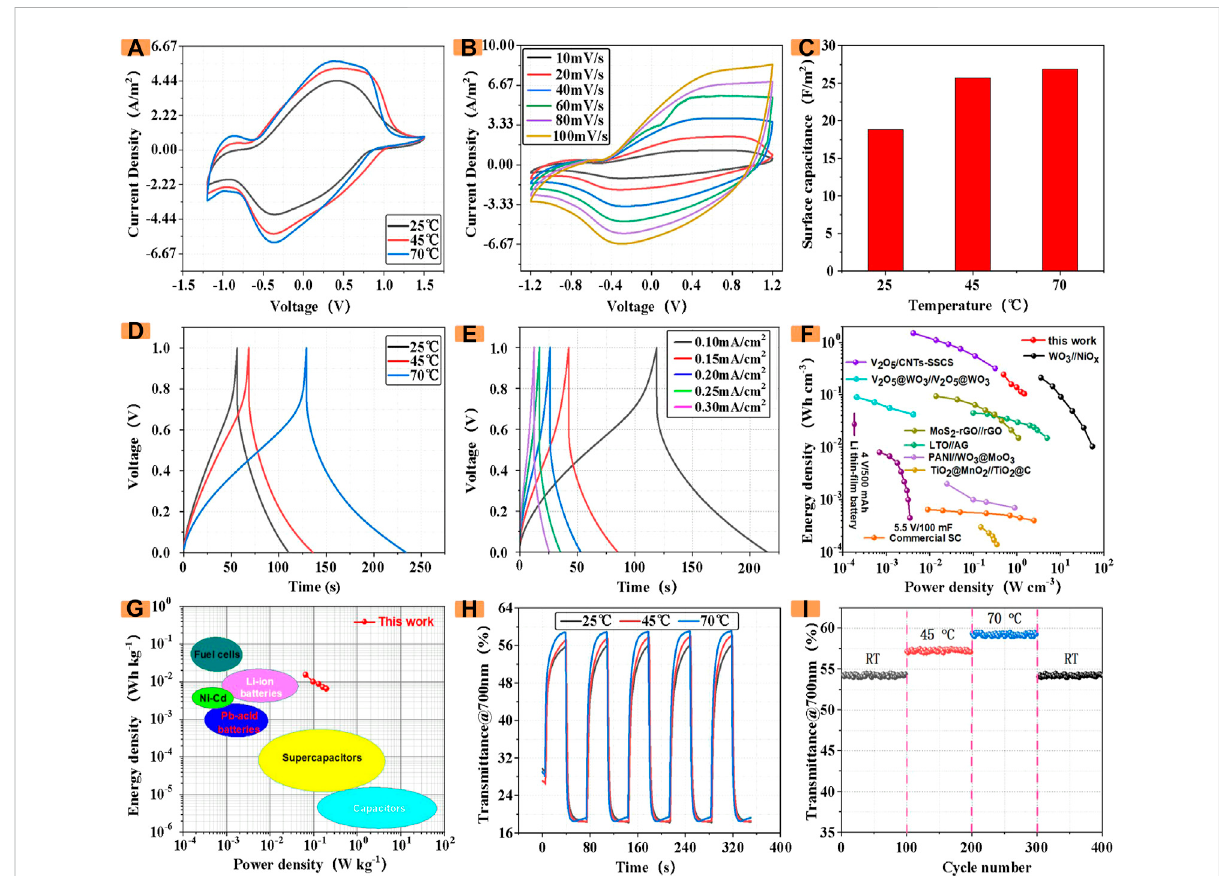
FIGURE 6 (A) CV at different temperatures (B) CV curves at different scan rates (C) In fl uence of temperature on area capacitance (D) GCD at different temperatures (E) GCD pro fi les at various current densities (F,G) Ragone plots in compared with other similar works and some representative